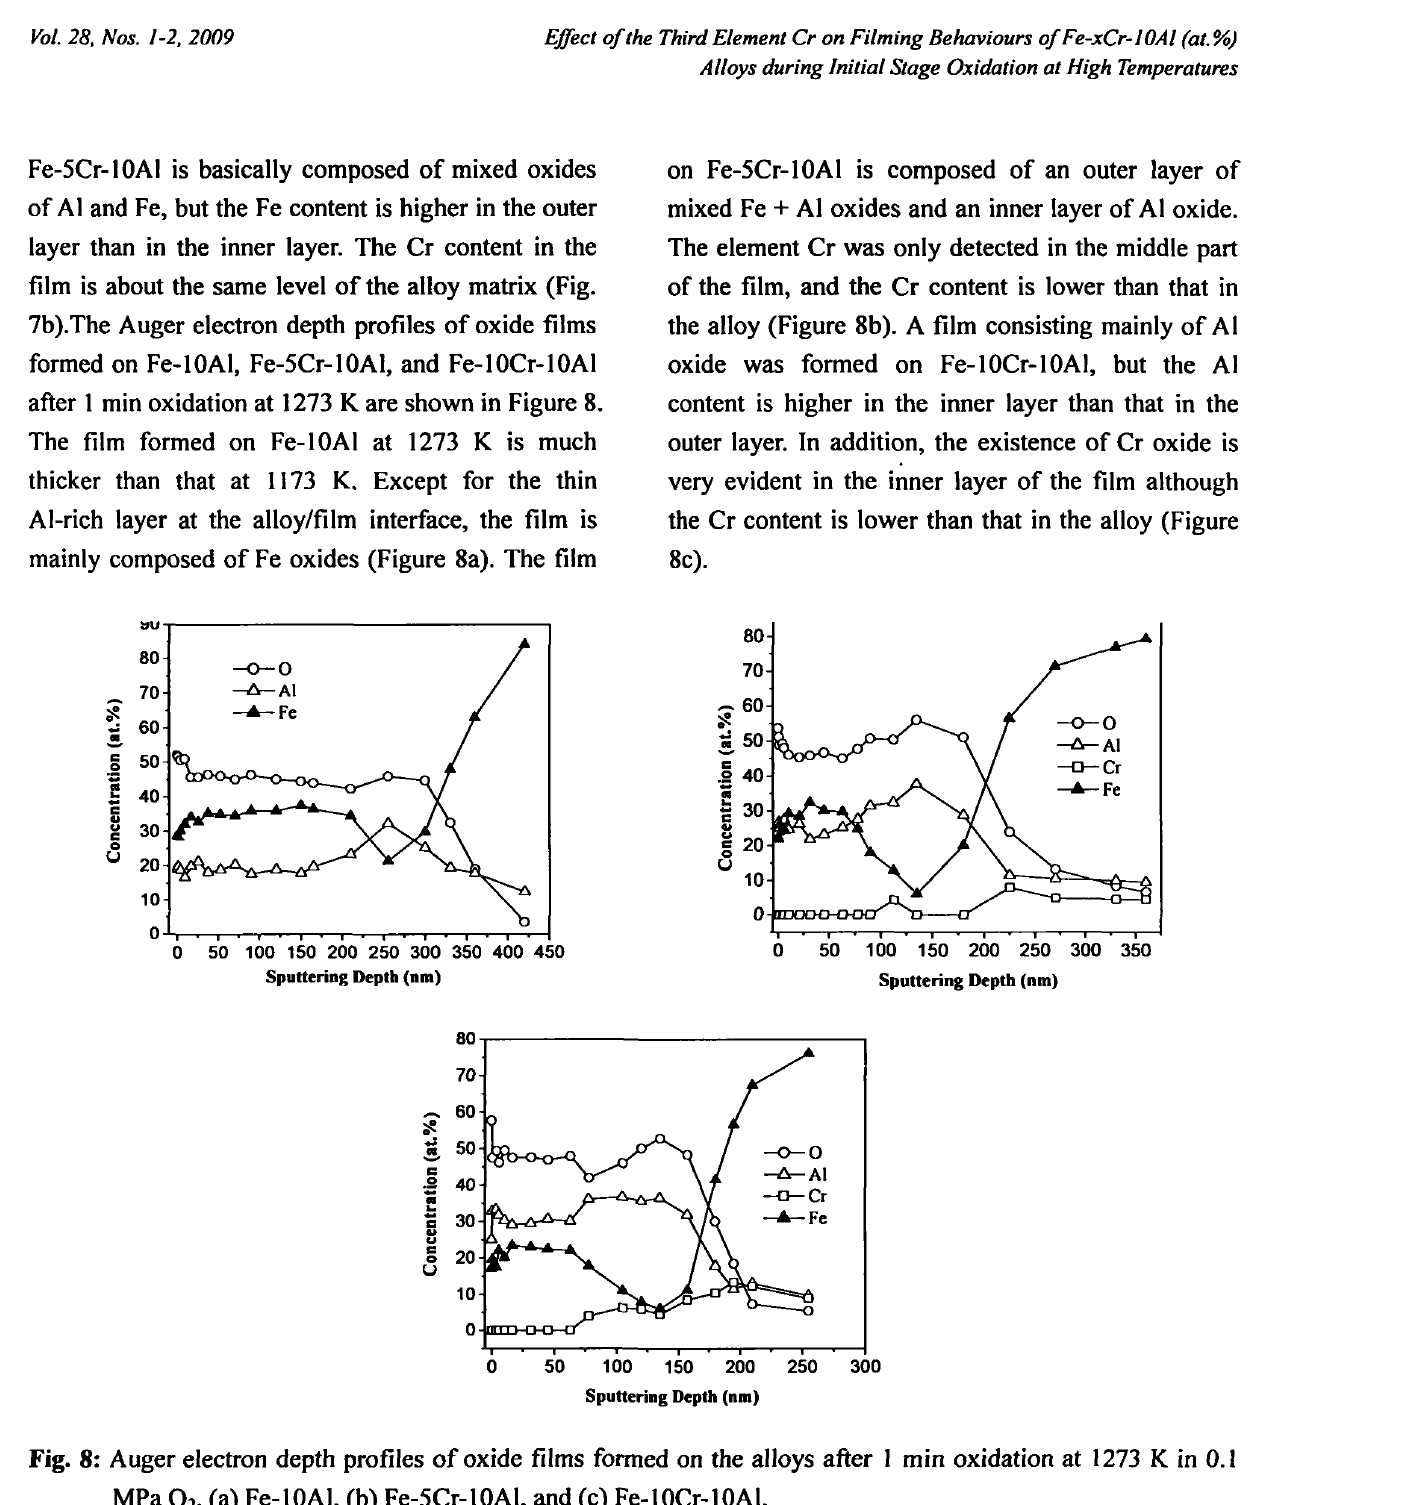
Fig. 8: Auger electron depth profiles of oxide films formed on the alloys after l min oxidation at 1273 K in 0.1 MPa O . (a) Fe-10Al, (b) Fe-5Cr-10Al, and (c) 2